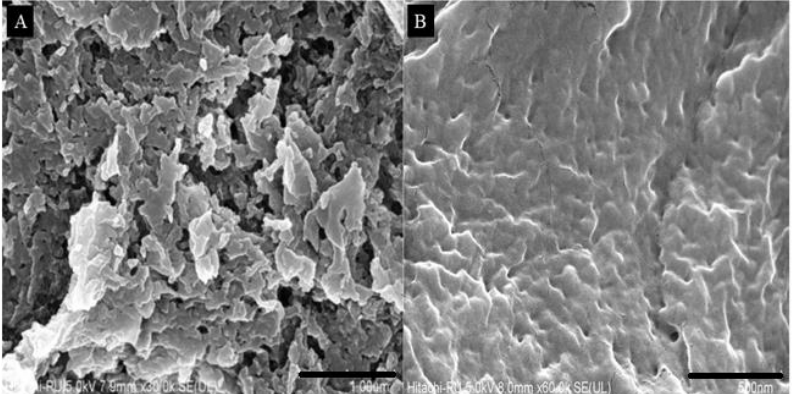
Figure 6. Field emission scanning electron microscopy images of ( A ) blank nanosponges (NS), and ( B ) bioactive-loaded selected batch (SES-NS6).